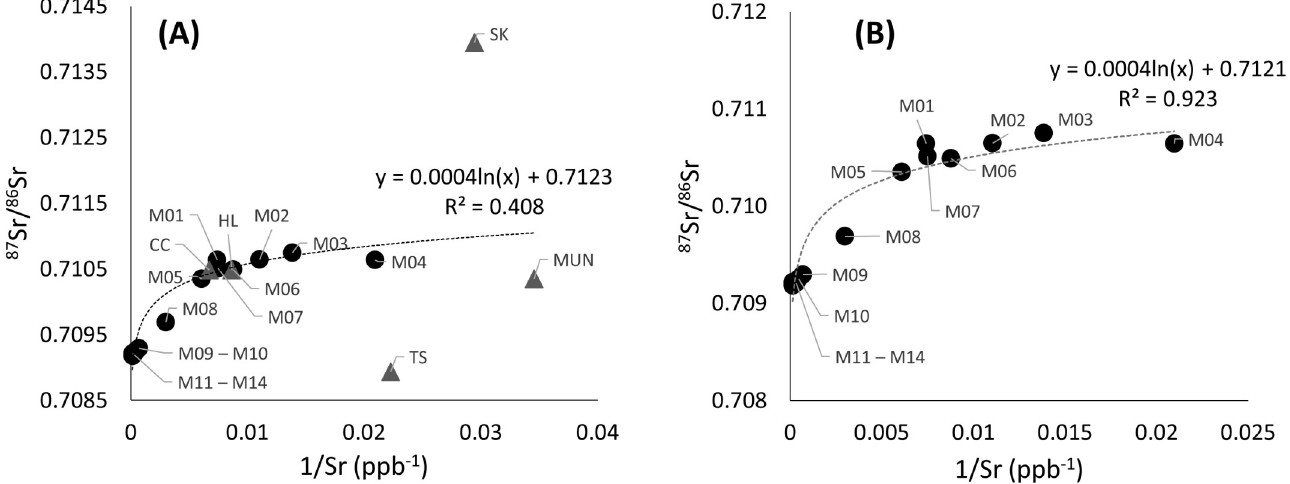
Fig 5. Water 87 Sr/ 86 Sr against 1/Sr. Water 87 Sr/ 86 Sr versus 1/Sr along the Mekong River; (A) with and (B) without tributaries and distributaries. Labels at each point refer to the sampling sites in Fig 1 and Table 1. Black circles indicate sites on the Mekong mainstream, grey triangles indicate sites belonging on tributaries and